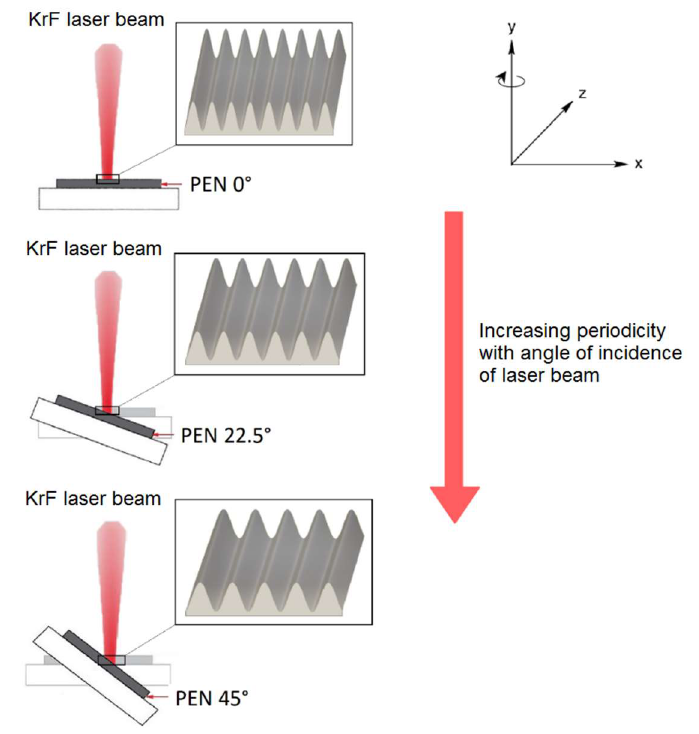
Figure 2. Scheme of surface nanostructuring of polyethylene naphthalate (PEN) by KrF excimer laser irradiation under incidence angles of 0, 22.5 and 45° [80] .